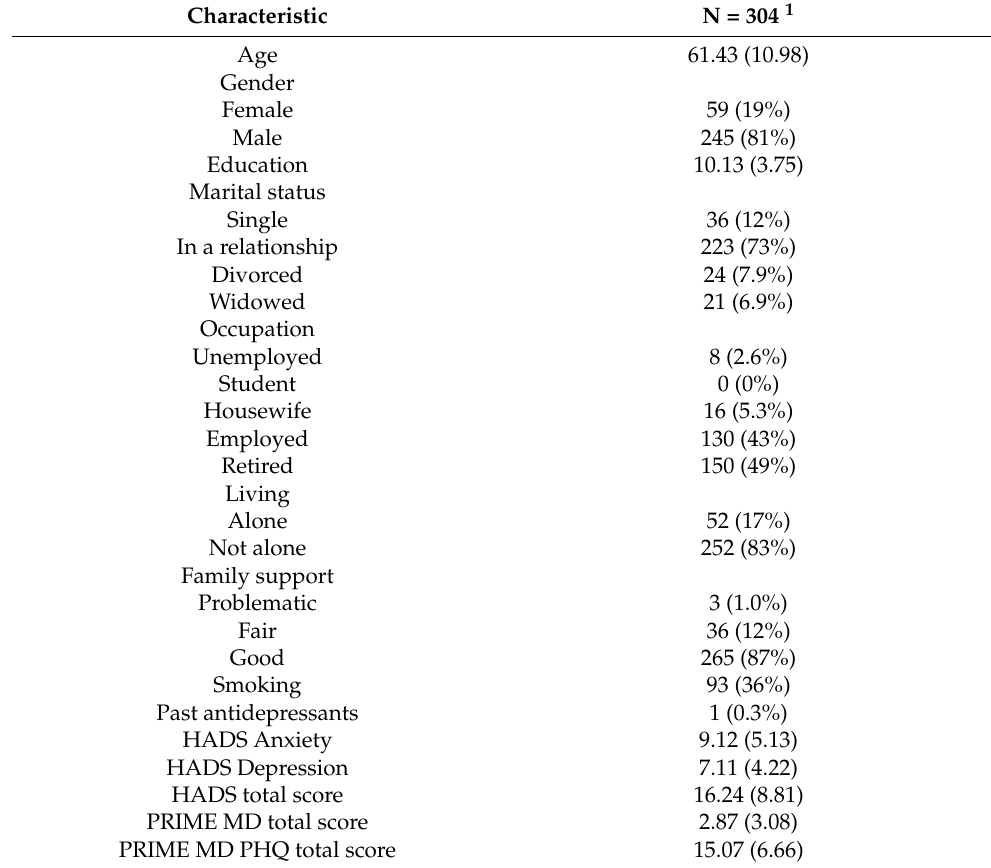
Table 1. Sample characteristics. 1 Mean (SD); n (%). HADS: Hospital Anxiety and Depression Scale; PRIME-MD: Primary Care Evaluation of Mental Disorder; PHQ: Patient Health Questionnaire; TCI: Temperament and Character Inventory; DS-14: Type D Personality Scale; TAS-20: Toronto Alexithymia Scale, 20-item; DSQ-40: Defense Style